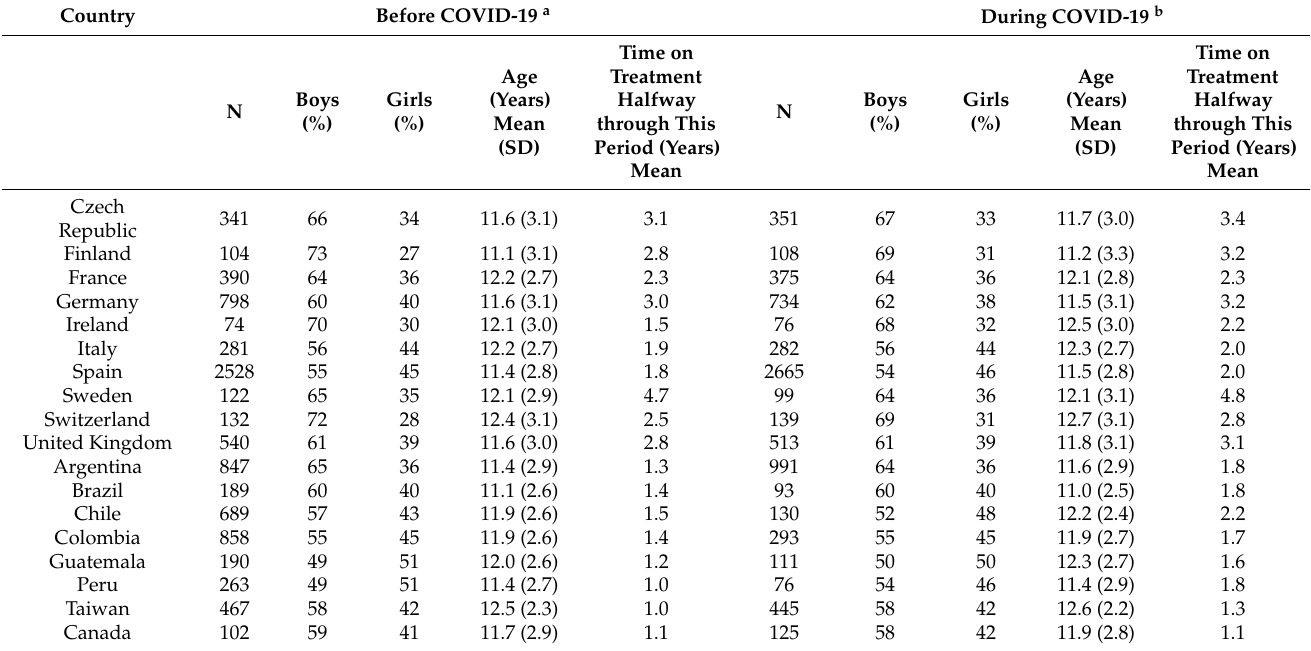
Table 1. Demographics for all patients before and during the COVID-19 period, by